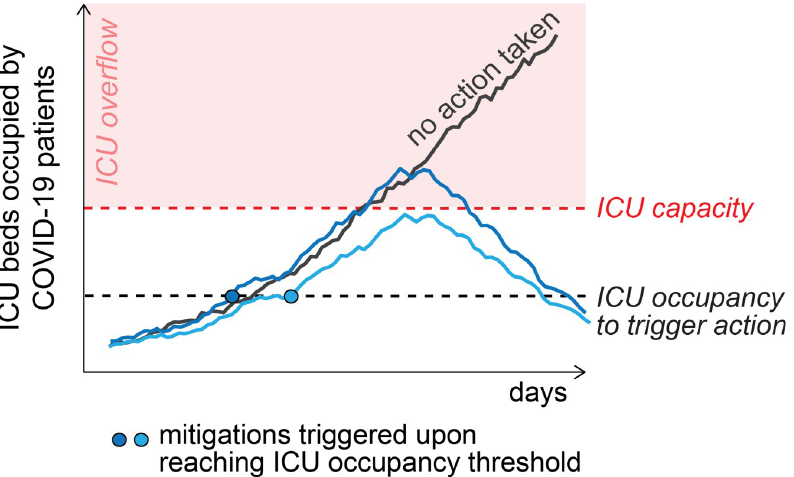
Fig 1. Conceptual visualization of ICU occupancy when mitigation is triggered compared to no action taken. The dashed red line indicates ICU capacity. The solid black line shows the scenario when no action is taken and ICU occupancy exceeds the ICU capacity, leading to ICU overflow (red area). The blue lines show two example scenarios in which mitigation was triggered at the same specified threshold (dashed black line). In one scenario (light blue) ICU overflow is prevented, and in the second scenario (dark blue) ICU capacity is still exceeded. This demonstrates that the effectiveness of mitigation measures is probabilistic, not absolute.